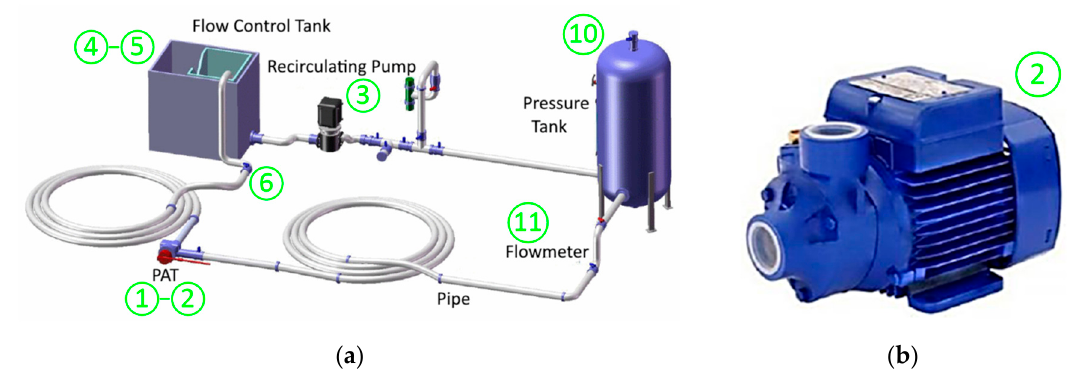
Figure 13. Experimental hydraulic circuit: ( a ) circuit schematic and ( b ) PAT used (Etanorm 32-125 KSB 4.8).